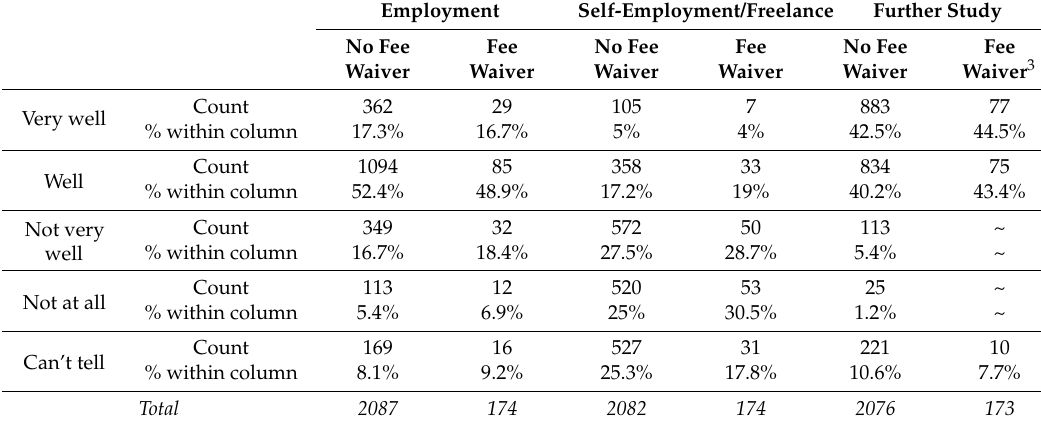
Table 4. Perceived preparedness by fee waiver